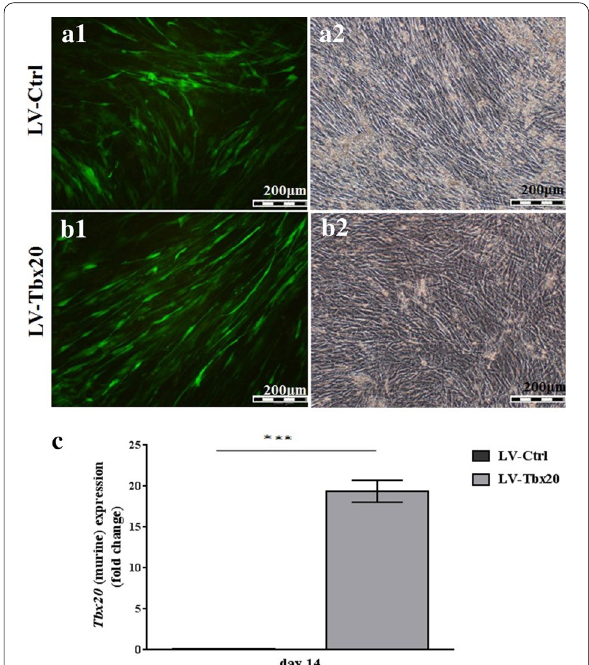
Fig. 2 Fluoromicrographs ( a1 , a2 ) and brightfield images ( b1 , b2 ) of LV‑Ctrl ( a1 , b1 )‑ or LV‑ Tbx20 ( a2 , b2 )‑transduced Ad‑MSCs that were maintained in osteogenic differentiation medium for 21 days. c Expression of Tbx20 (murine) in transduced cells, 14 days after transduction. RT‑qPCR demonstrated that the Tbx20 expression in LV‑ Tbx20 transduced cells was around 20 times higher than its expression in LV‑Ctrl transduced cells.***Indicates significant differences ( p < 0.001) between LV‑Ctrl and LV‑